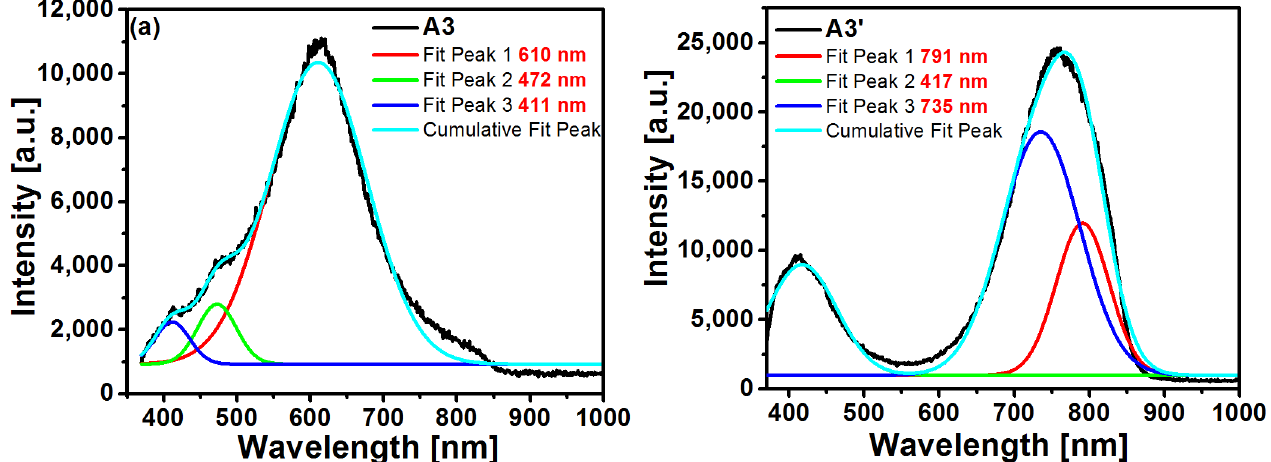
Figure 7. Deconvolution of PL spectra of A3 films without ( a ) and thermally annealed ( b ).